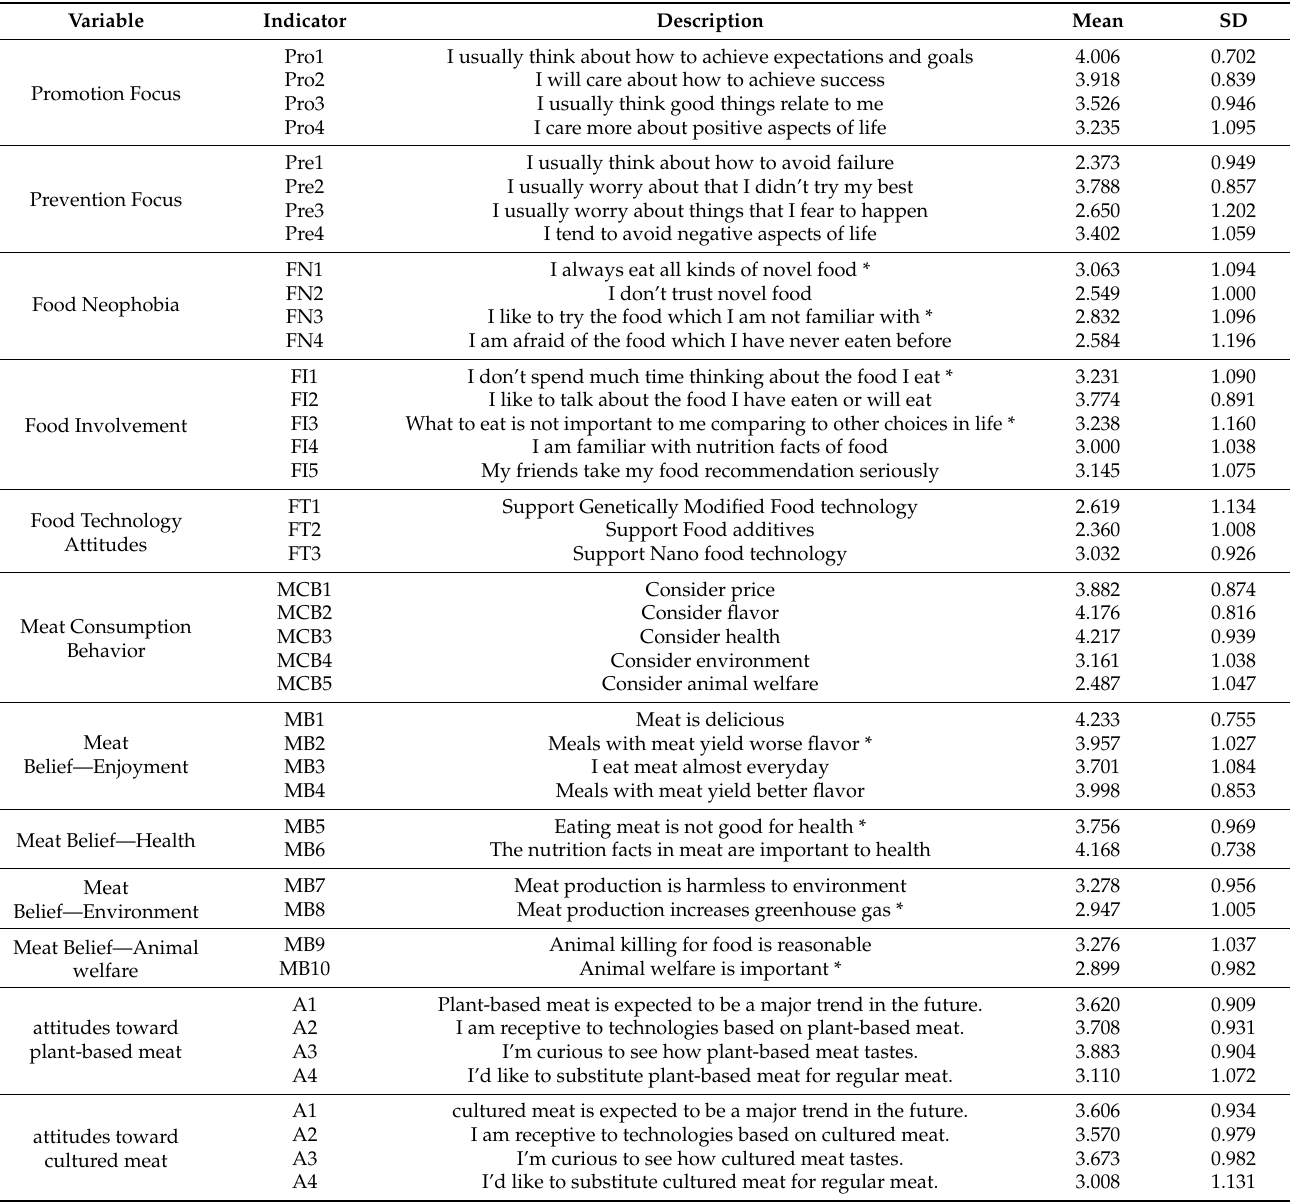
Table A3. Variable